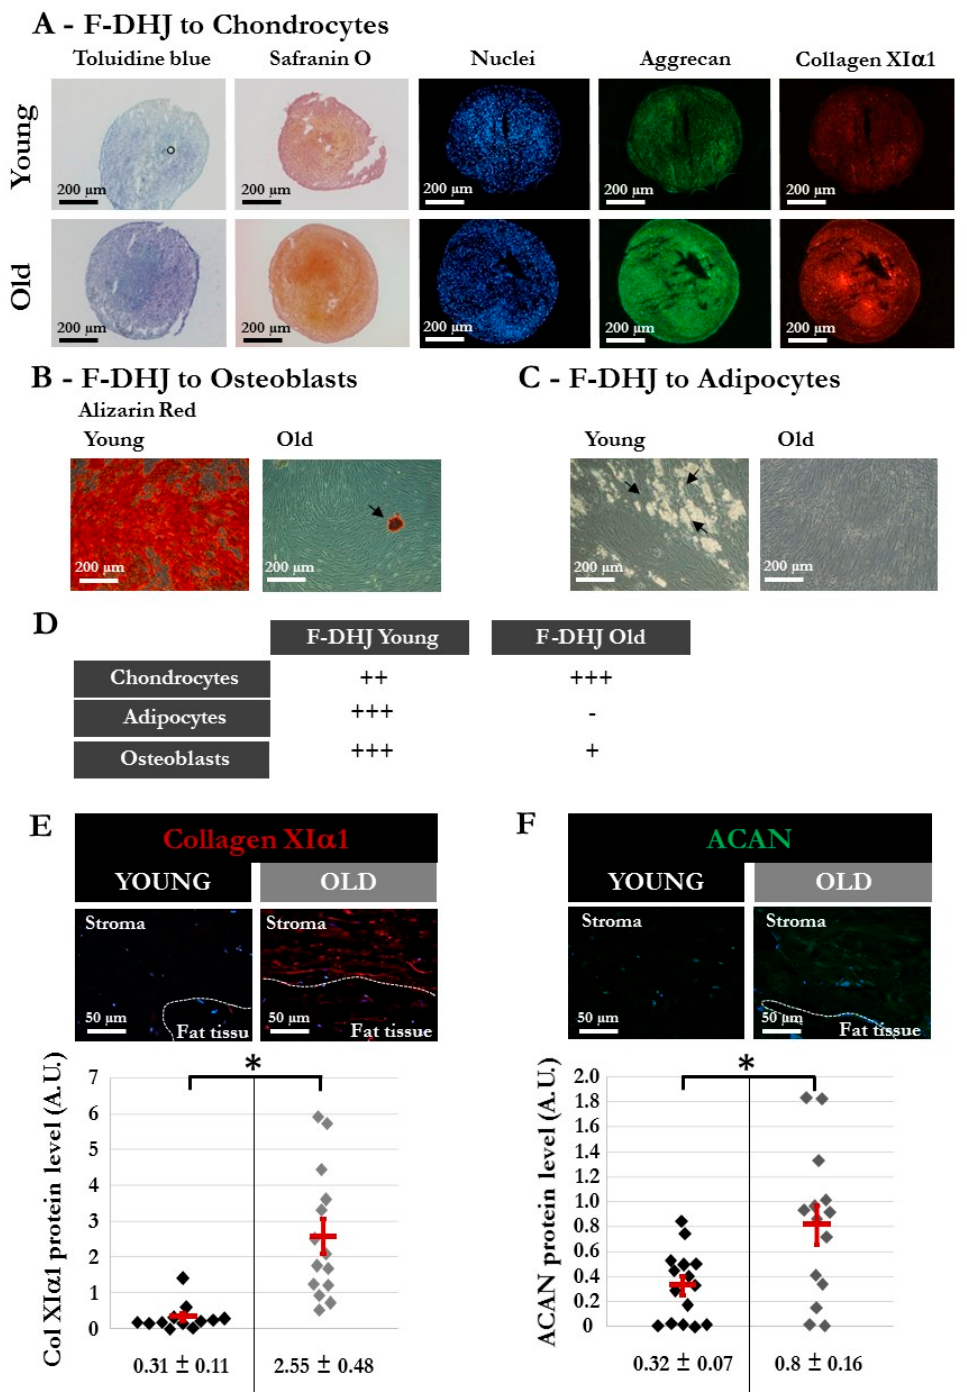
Figure 8. Different characteristics of DHJ components in skin from “young” and “old” donors. The “young” group comprised 5 donors (20, 22, 25, 28, and 31 years old) (same donors as in Figure 3), and the “old” group comprised 4 donors (55, 61, 65, and 65 years old). ( A–C ) Capacity of “young” and “old” F-DHJ cells to differentiate in vitro into three mesenchymal lineages: ( A ) chondrocytes (toluidine blue and safranin O staining, aggrecan (ACAN) and collagen XI α 1 (ColXI α 1) expression); ( B ) adipocytes (presence of cytoplasmic lipid droplets, black arrows); and ( C ) osteoblasts (alizarin-red staining). For panels ( A–C ), representative photographs are shown. ( D ) Summary of the differentiation capacity into chondrocytes, adipocytes, and osteoblasts of F-DHJ from “young” and “old” skin. Scoring of di ff erentiation capabilities are presented: ( − ) = not present, (+) = low representation, (++) = frequent representation, and (+++) = major representation. ( E , F ) Immunofluorescence detection of ColXI α 1 ( E ) and ACAN ( F ) in skin biopsies from “young” and “old”